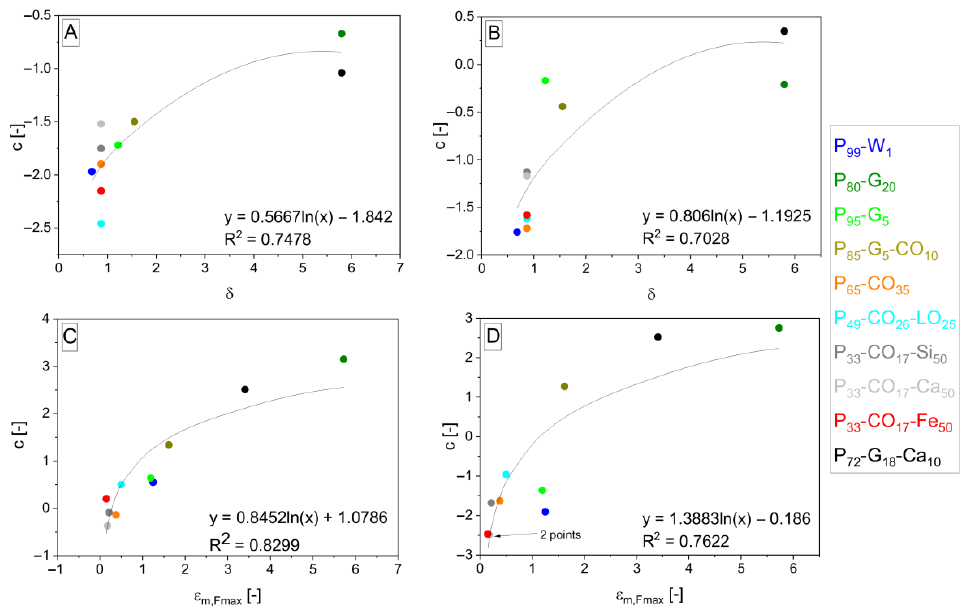
Figure 7. Logarithmic dependencies y = f + g · ln x of parameters c from general Equation (10) with different c values according to specification of property z into E ( A ), σ Fmax ( B ), ε Fmax ( C ), and A Fmax ( D ) interpolated by δ ( A , B ) and ε m,Fmax ( C , D ) values from Table 1 ( δ ) and Table 4 ( ε m,Fmax ). The resulting dependencies correspond to exponent f + g · ln x in Equations (12) – (15) arising from Equation (10) in the order from ( A ) to ( D ).